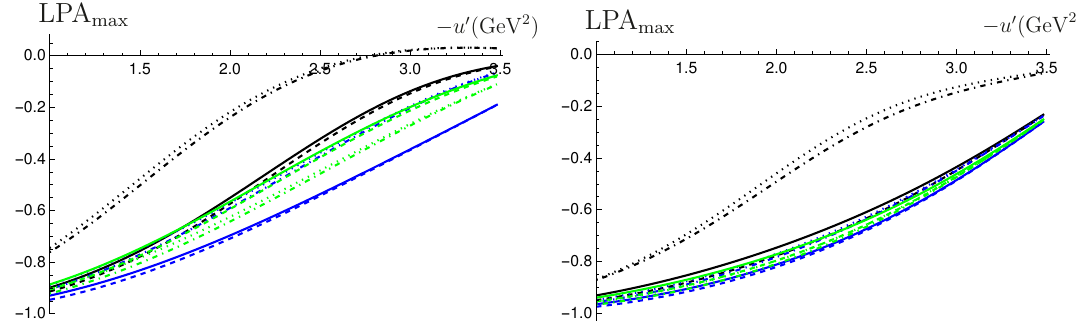
Figure 19 . The LPA at the fully-differential level for π + ( π − ) is shown as a function of ( − u 0 ) on the left (right), using M 2 = 4 GeV 2 and S = 200 GeV 2 . The black curves correspond to the total γN γπ contribution, i.e. vector and axial GPD contributions combined. As before, the dashed (non-dashed) lines correspond to holographic (asymptotic) DA, while the dotted (non-dotted) lines correspond to the standard (valence) scenario. Note that the vector contributions consist of only two curves in each case, since they are insensitive to either valence or standard scenarios. The effect of using the valence or standard scenario is significant, while the difference between using asymptotic and holographic DA is minimal.